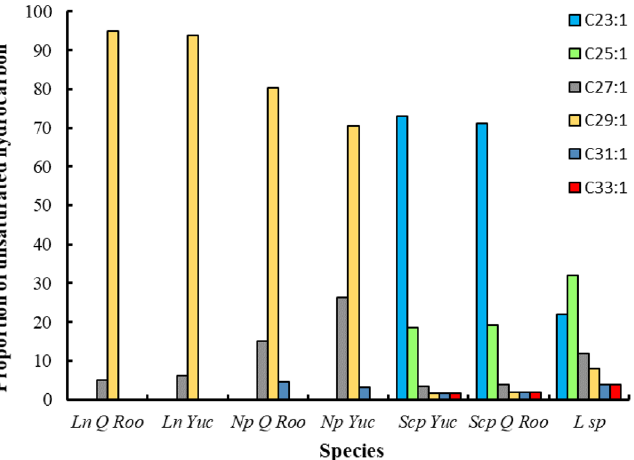
Figure 2. Proportion of unsaturated cuticular hydrocarbons present in Lestrimelitta sp ., L. niitkib and potential host species from Yucatan and Quintana Roo. Ln, L. niitkib ; Np, N. perilampoides ; Scp, S. pectoralis ; Yuc Yucatán; Q Roo Quintana Roo; L sp, Lestrimelitta sp.